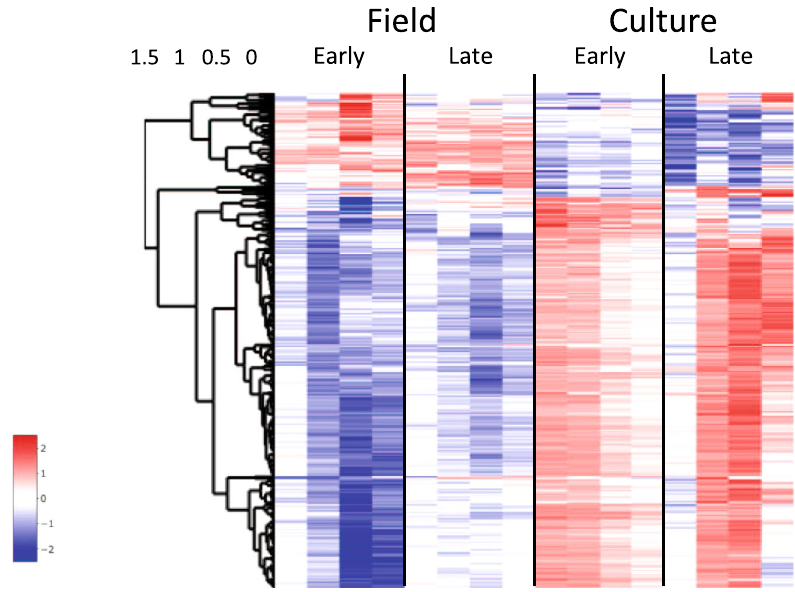
Fig. 8 Expression heatmap showing z-scores of DEGs involved in RNA metabolism. Differentially expressed genes between fi eld/diapause program and culture/reproductive program and early and late CV copepodids annotated with the GO term ‘ RNA metabolic process ’ [GO: 0016070] or its child terms ( n = 335). Color-coding for each gene indicates the magnitude of expression as z-scores of each individual sample. Relative expression of each sample is given in a separate column (ordered by group) as labeled at the top. Genes (rows) were ordered by hierarchical